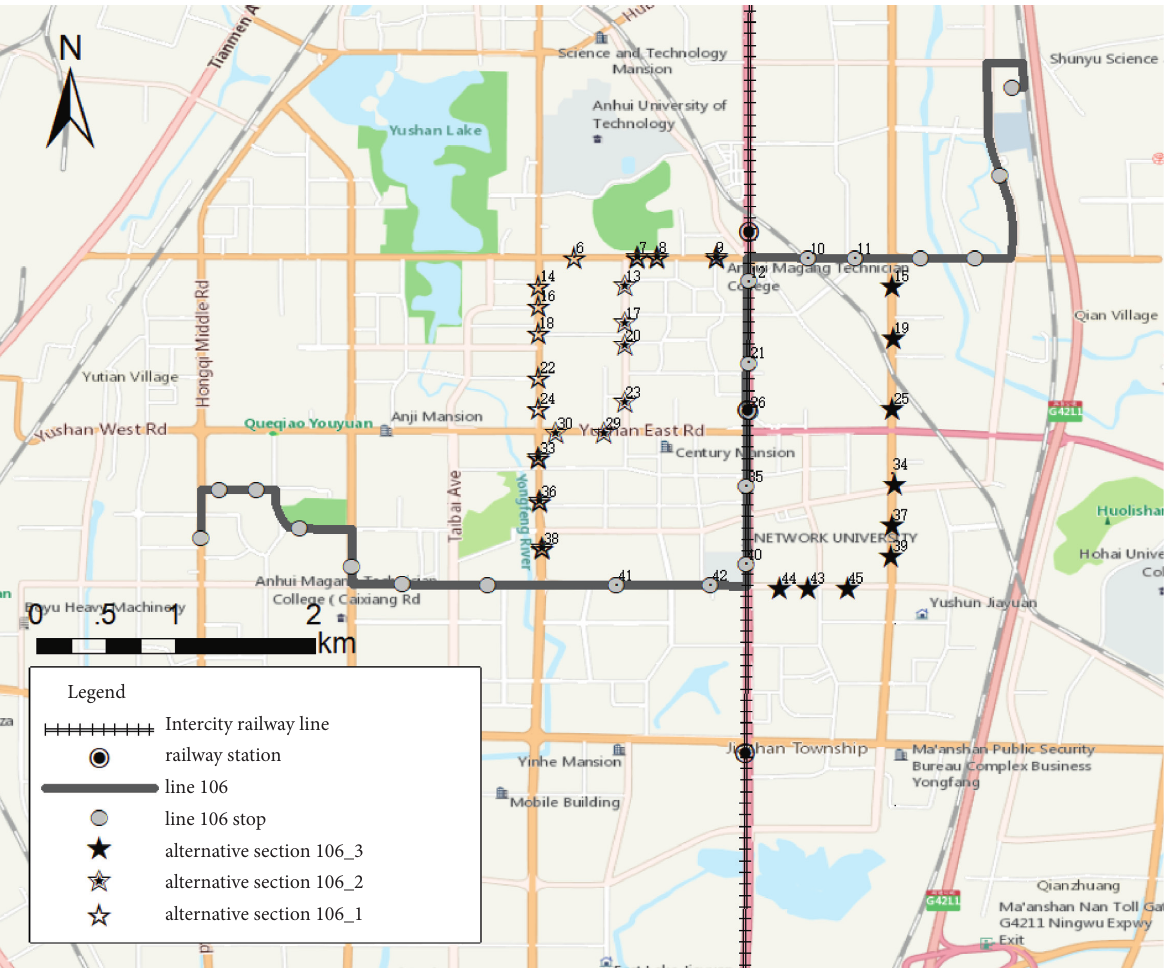
Figure 7: Alternative plans and stops of line